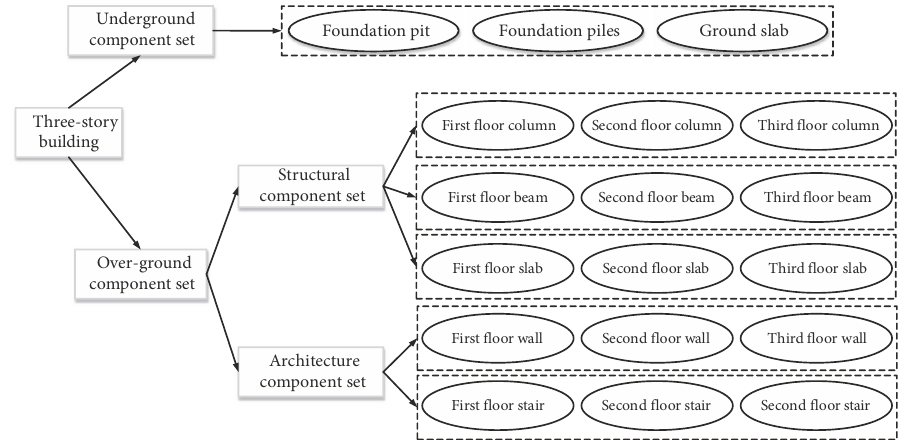
Figure 4. Hierarchical product model of a three-story